Question: What visual encoding does this figure use to show its data?
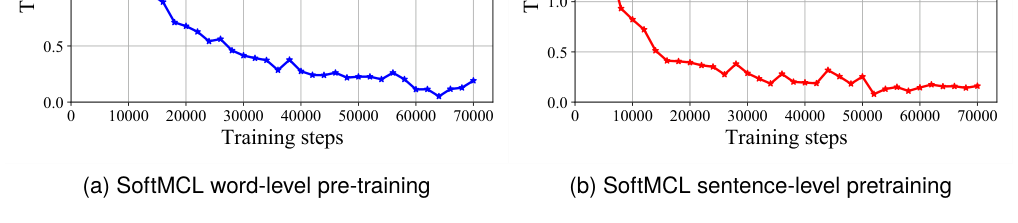
Answer: line